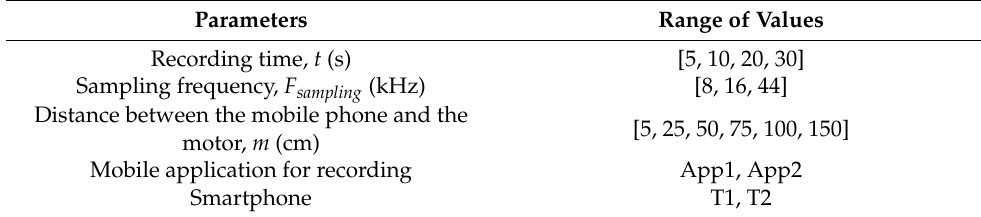
Table 2. Range of values selected for the parameters along the tests. Parameters Range of